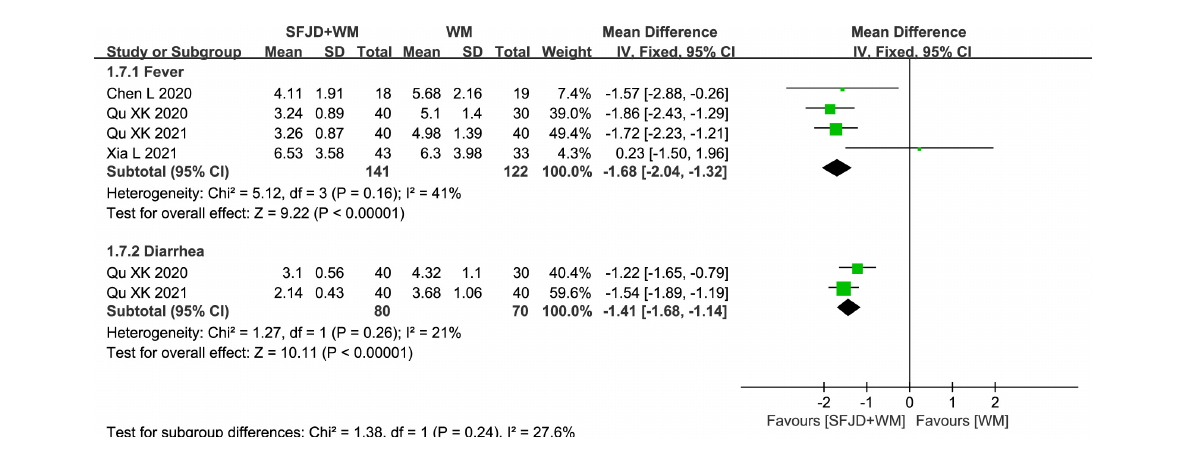
FIGURE7 Meta-analysis on symptom disappearance time in the SFJD + WM group vs. the WM group in COVID-19 patients (fixed effect model).